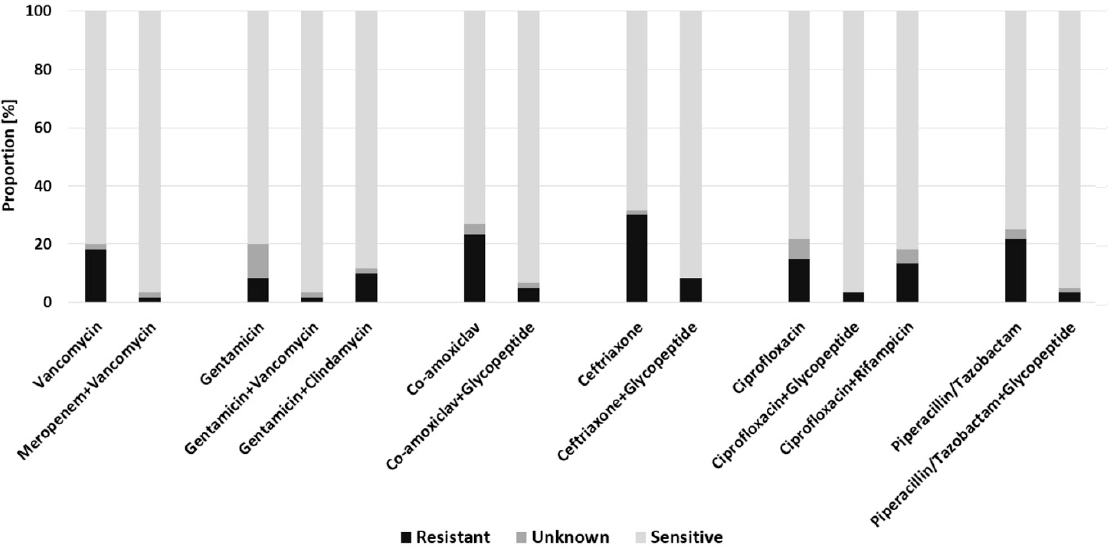
Figure 3. Predicted efficacy of empiric antimicrobial regimens for patients with delayed-onset of infection.